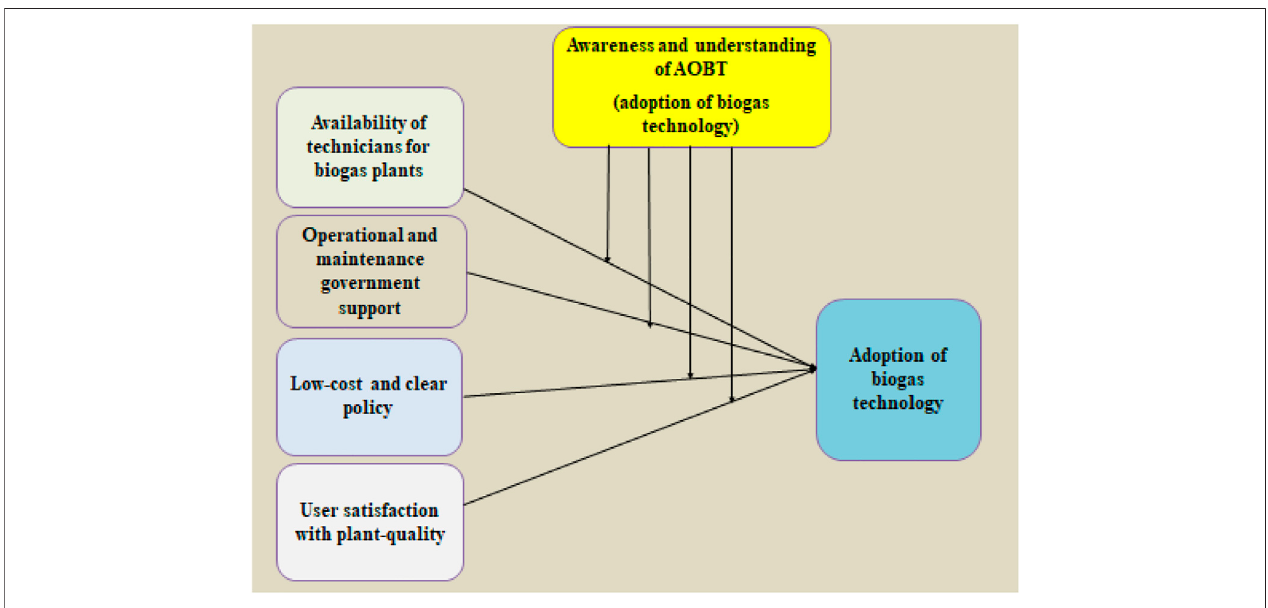
FIGURE 1 | Conceptual